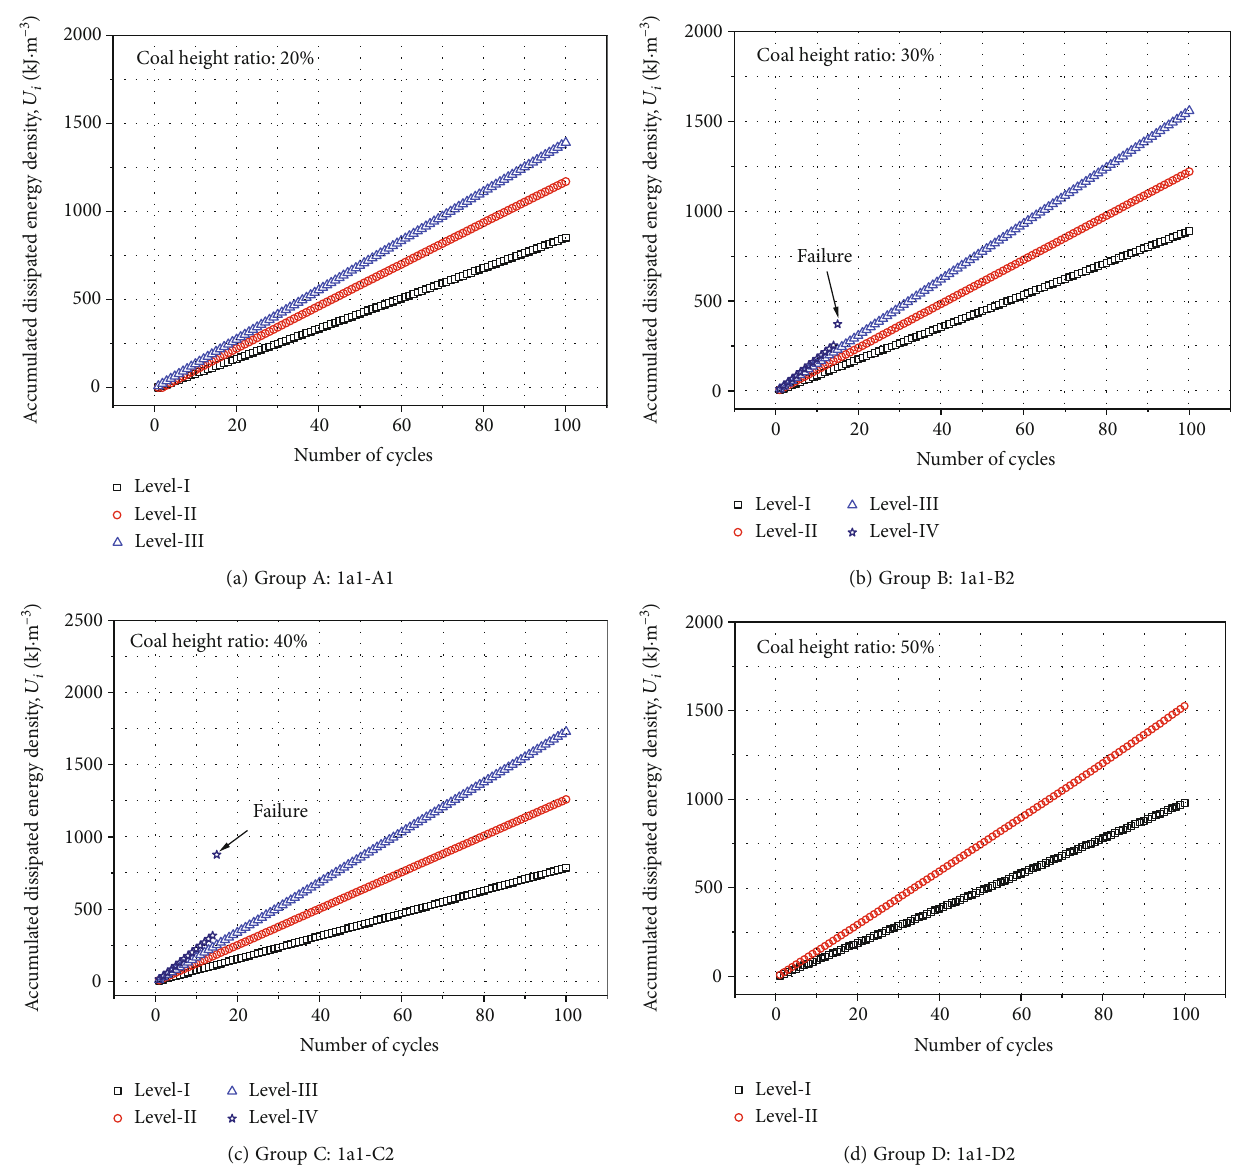
Figure 8: Accumulated dissipated energy density of